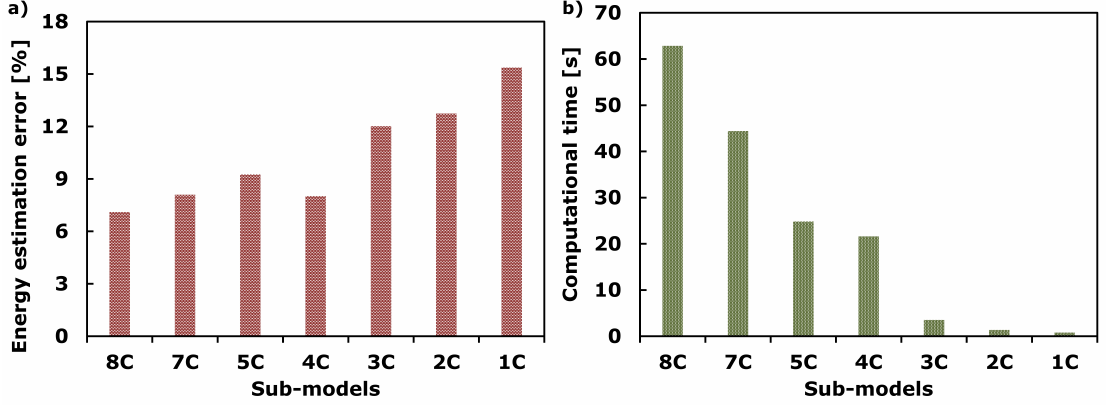
Figure 12. Trade-off between ( a ) model accuracy and ( b ) computational